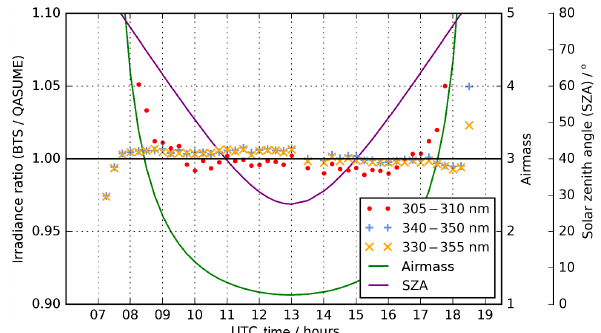
Figure 5. BTS / QASUME ratio of the wavebands used for the cal- culation of TOC values. The measurements were performed on 20 September 2016. The corresponding air mass of the direct ir- radiance and the solar zenith angle on the corresponding day are also shown (right axis). For solar zenith angles of more than 74 ◦ or an air mass above 3.6, deviations rise to 5%.